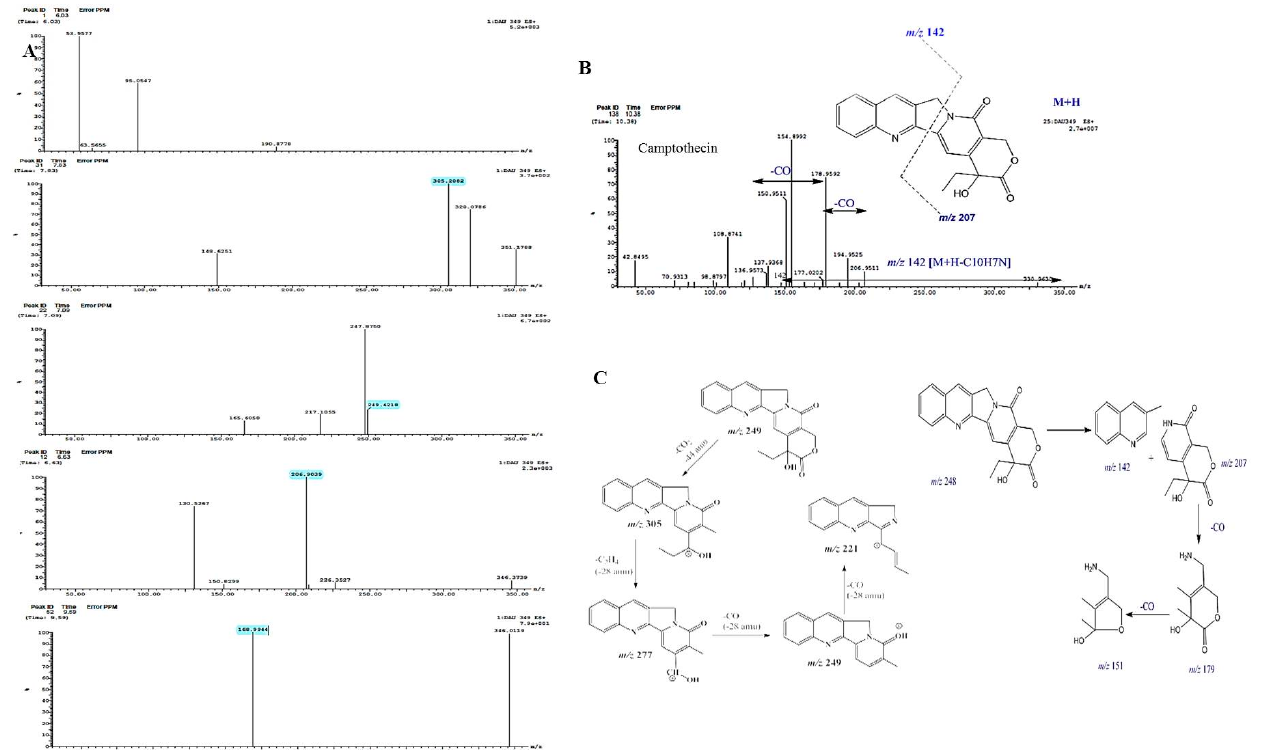
Figure 4. Chemical validation of the extracted camptothecin from P. chrysogenum . The putative spots of camptothecin were scraped-off from the TLC, and its purity was checked by HPLC. ( A ), LC-MS/MS fragmentation pattern of putative camptothecin from P. chrysogenum . ( B ), LC MS/MS spectra of the putative purified camptothecin with the onset chemical structure of camptothecin. ( C ), Scheme of molecular fragmentation pattern of camptothecin as revealed by the LC-MS/MS spectra.